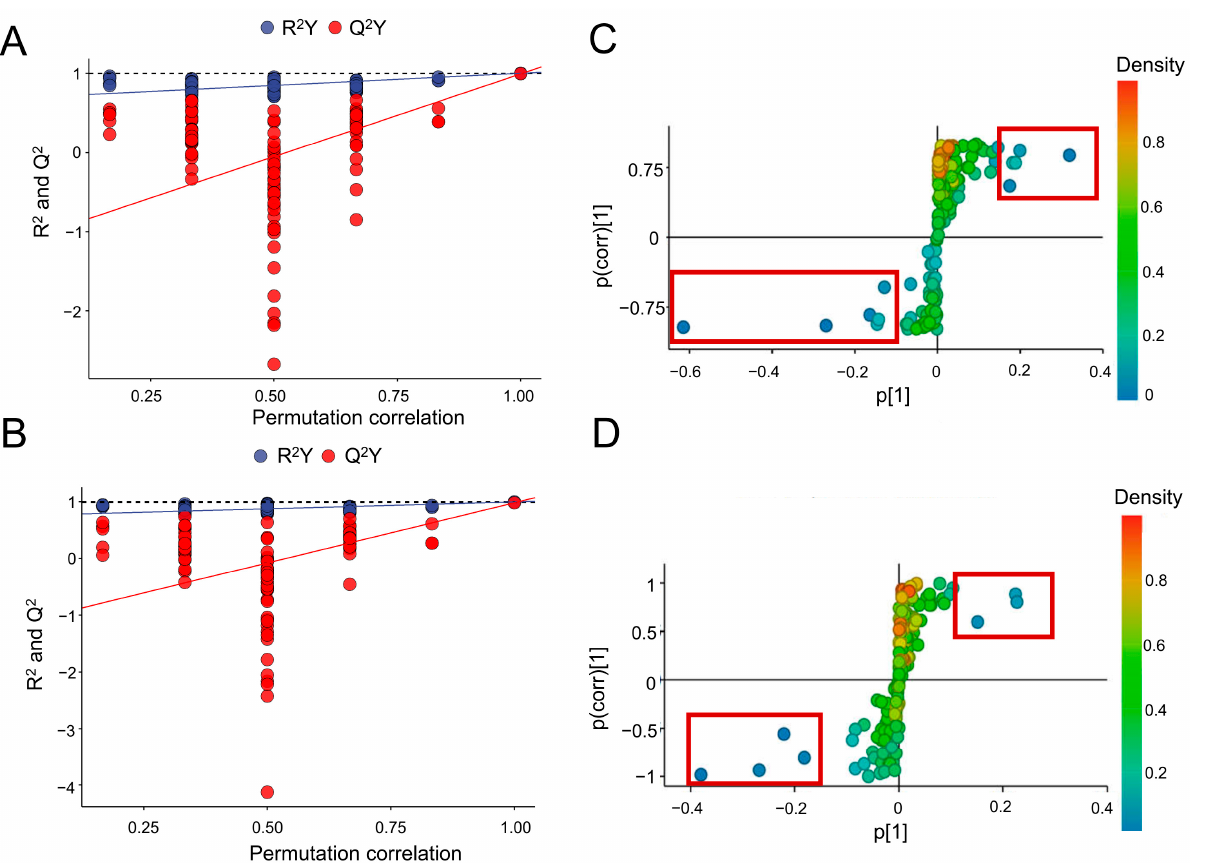
Figure 3. OPLD-DA analysis of metabolites in PQ-induced A549 cells with or without Del. ( A ) and ( B ) The permutation results with 200 iterations of metabolites in PQ and Del treatment groups. The corresponding intercept values of R 2 were 1 and 1, Q 2 were − 0.429 and − 0.263, respectively. ( C ) and ( D ) S-plot of OPLS-DA analysis of metabolites in PQ and Del treatment groups. Metabolites in the left bottom and right top of the S-plot were potential biomarkers.